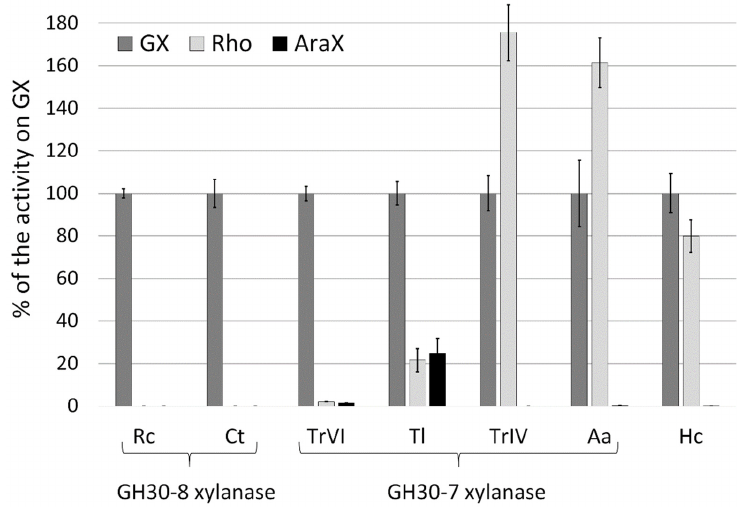
Figure 5. Relative specific activities of selected GH30 xylanases on Rho and AraX. The activity on GX is taken as 100%.